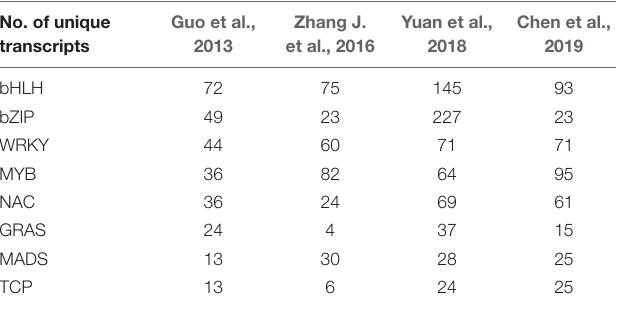
TABLE 3 | Transcription factor families identified in the medicinal Dendrobium transcriptome